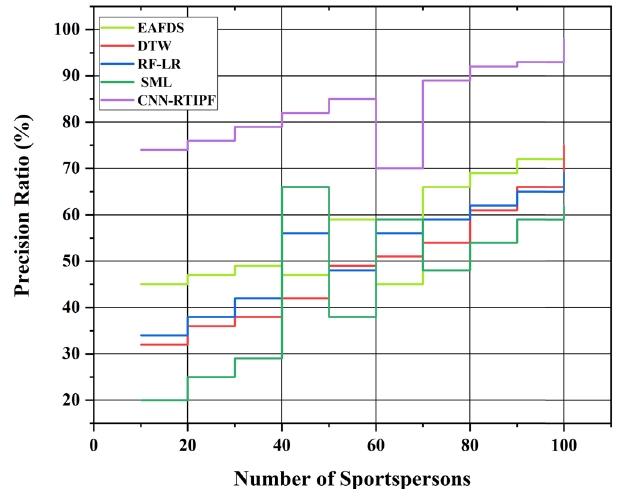
Figure 11: Precision ratio.